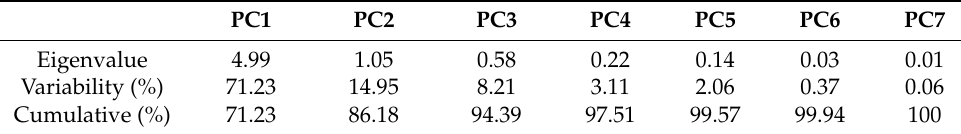
Table 3. Principal component analysis of EOX and PCB